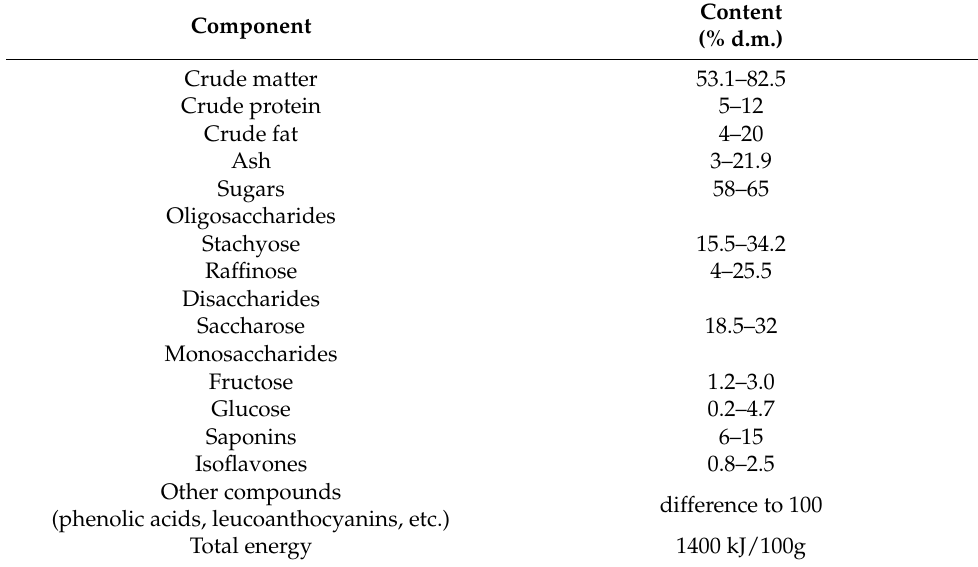
Table 1. Proximate chemical composition of soybean molasses